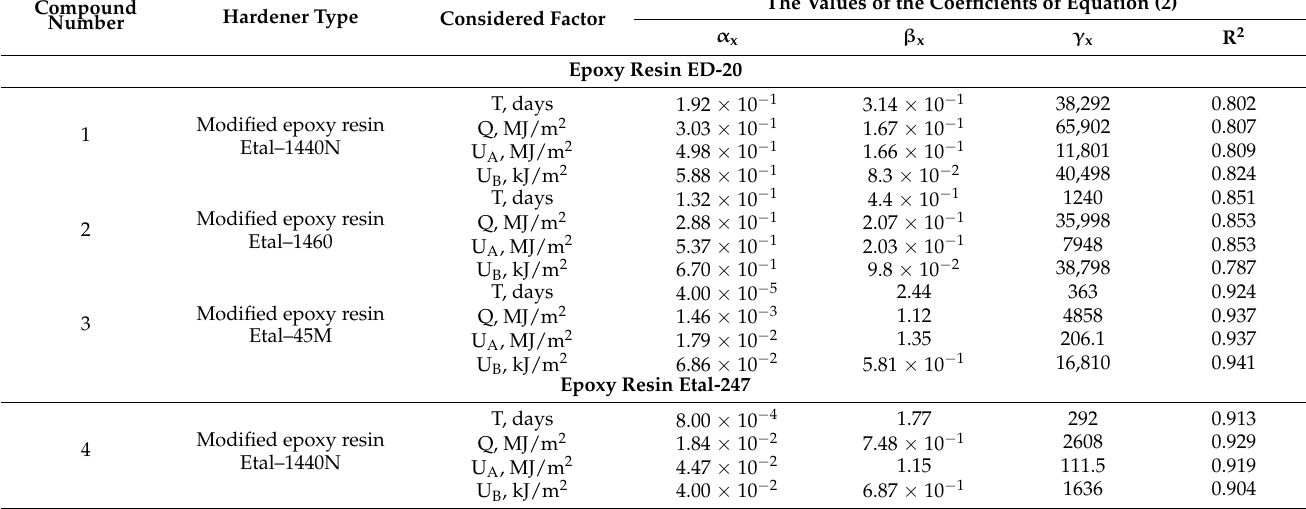
Table 4. The values of the coefficients of Equation (2), which describes the effect of the exposure time ( T ), the intensity of total solar radiation ( Q ) and ultraviolet radiation of the A ( U A ) and B ( U B ) ranges on the difference in the color tone of the epoxy polymers exposed to natural conditions